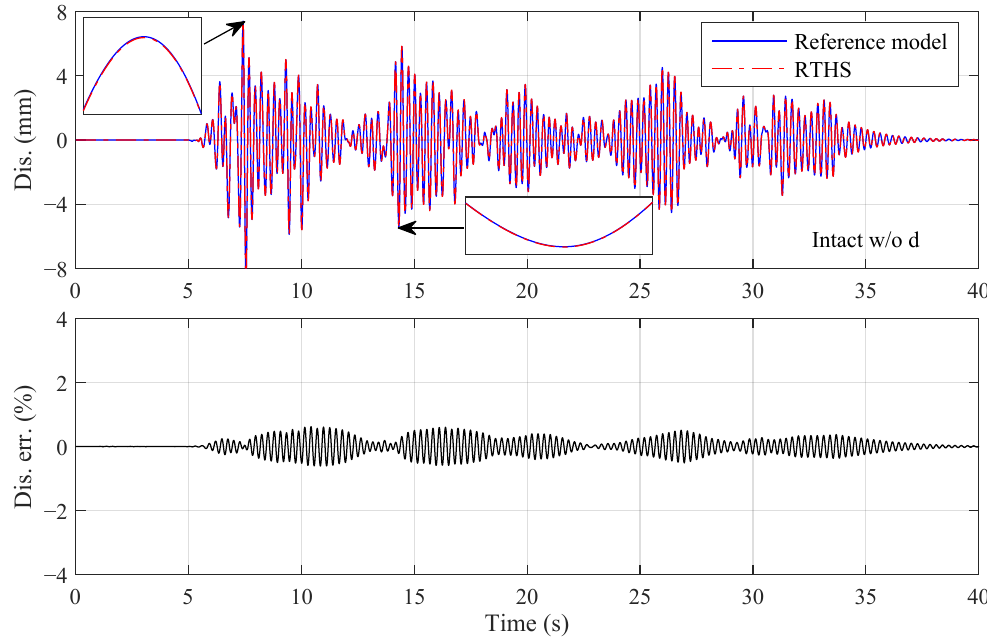
Figure 14. Third-floor displacement responses of Intact w/o d (El Centro earthquake, Case 4, perturbed plant).